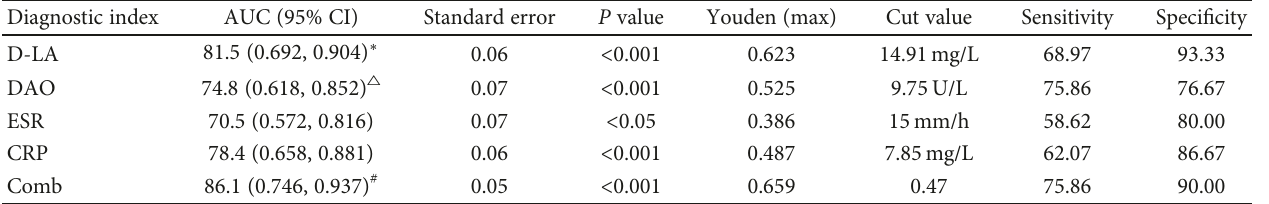
Table 3: Accuracy and ROC analyses of D-LA, DAO, ESR, and CRP in di ff erentiating CD active and CD remission. Diagnostic